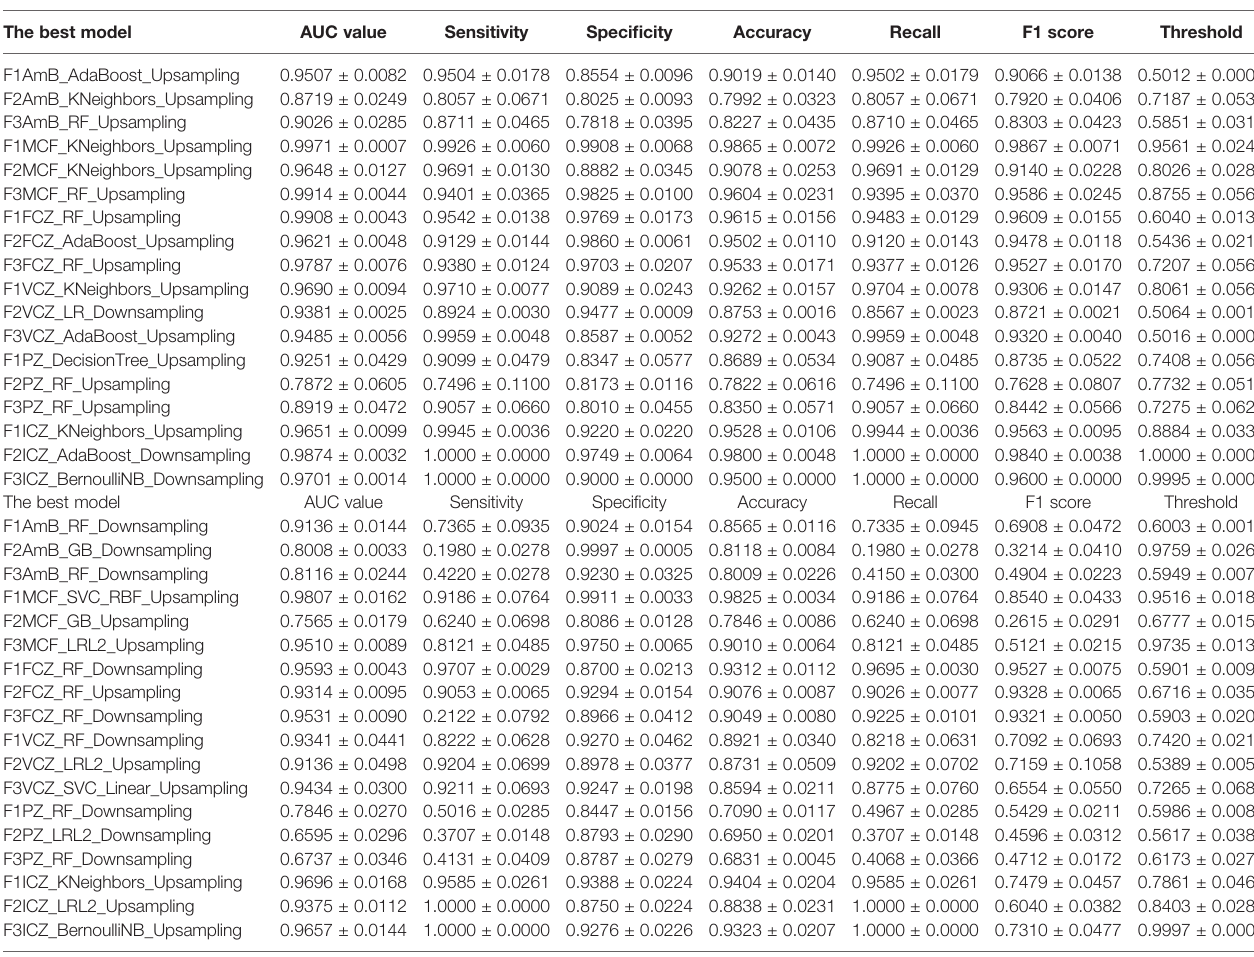
TABLE 2 | Model evaluation results under two different algorithms: on the balanced test set (the upper table) and on the imbalanced test set (the lower table). The best model AUC value Sensitivity Speci fi city Accuracy Recall F1 score